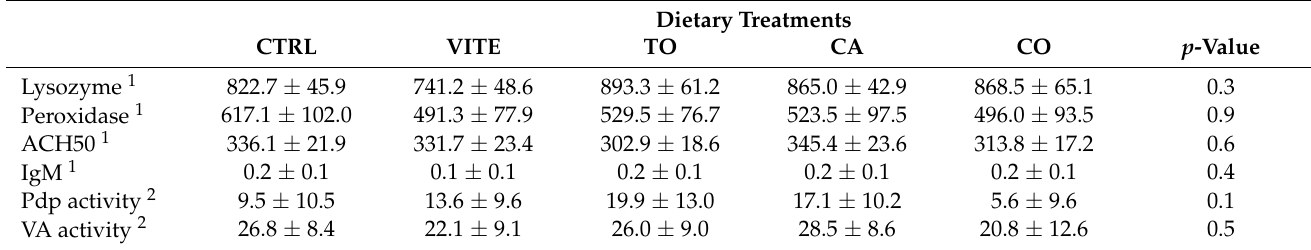
Table 5. Innate immune parameters of Dicentrarchus labrax evaluated after 87 days of feeding the experimental